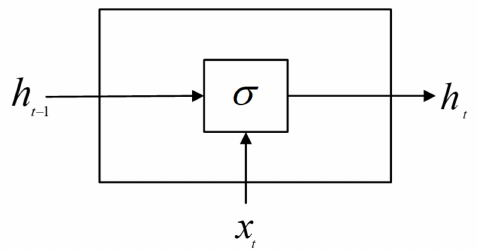
Figure 2. Simple Recurrent Neural Network (Simple